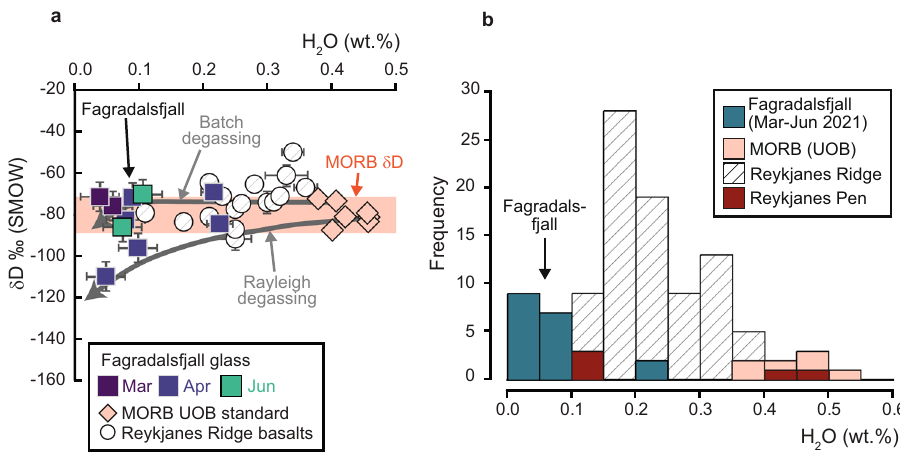
Fig. 6 Hydrogen isotope results. a δ D-H 2 O variation in glasses from the 2021 Fagradalsfjall eruption compared to the MORB UOB (University of Oregon Basalt) glass standard 30 . The δ D range for fresh MORB is drawn after ref. 29 . The mild decrease in δ D observed in some of the Fagradalsfjall samples is likely due to near-surface degassing (Batch and Rayleigh degassing curves shown from a starting composition similar to UOB). Reference data for Reykjanes Ridge basalts are plotted after ref. 62 . Analytical uncertainty decreases with increasing water content; error bars are displayed for low water samples and are otherwise smaller than symbol size. b Frequency distribution plot of H 2 O contents in Fagradalsfjall glasses, including samples with low water contents (0.00 – 0.03 wt.% H 2 O) that have no accompanying δ D values. There is no evidence for magma interaction with seawater or meteoric water that would hydrate the glass and cause an increase and decrease in H 2 O contents and δ D values, respectively. Additional H 2 O data for Reykjanes Ridge and Reykjanes Peninsula basalts are plotted after ref. 41 . Abbreviations as